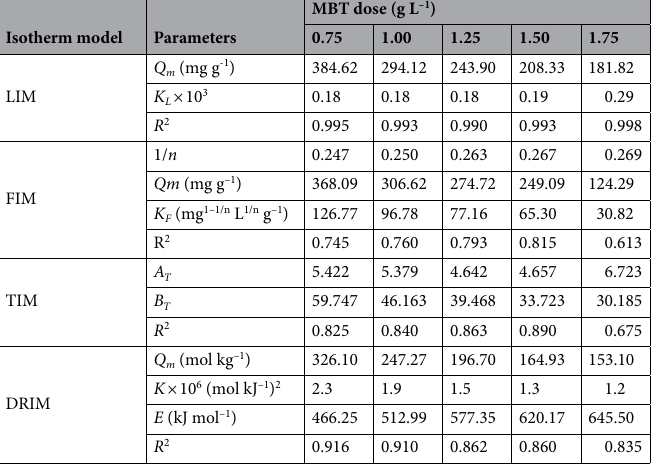
Table 1. For the purpose of determining the kind of adsorption, the binding energy ( E ) value is used. When look- ing at the estimated E values in Table 1, it can be shown that all MBT dosages have E value larger than 16 kJ mol –1 ,